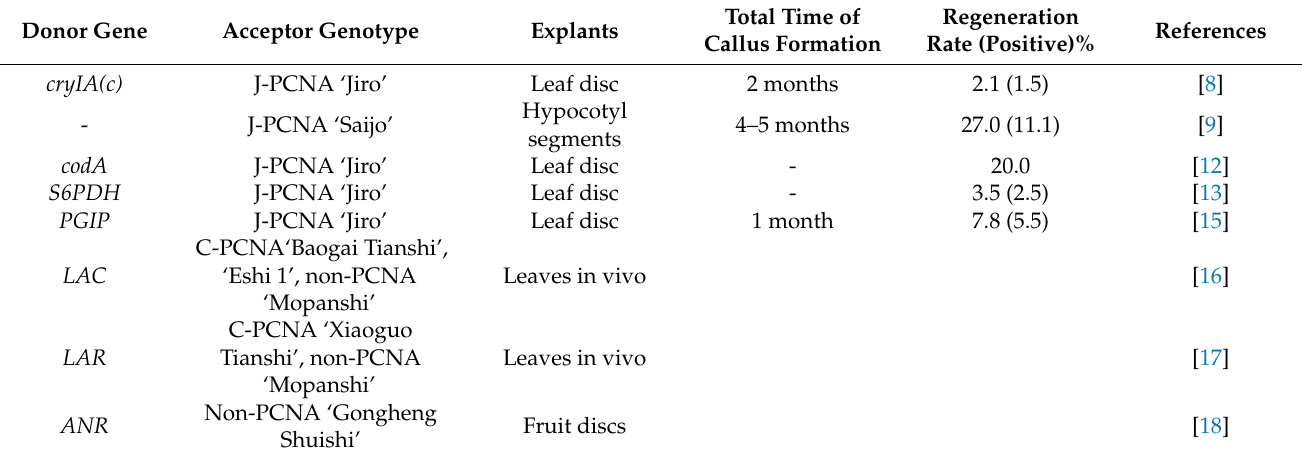
Table 1. Advancements of transgenic